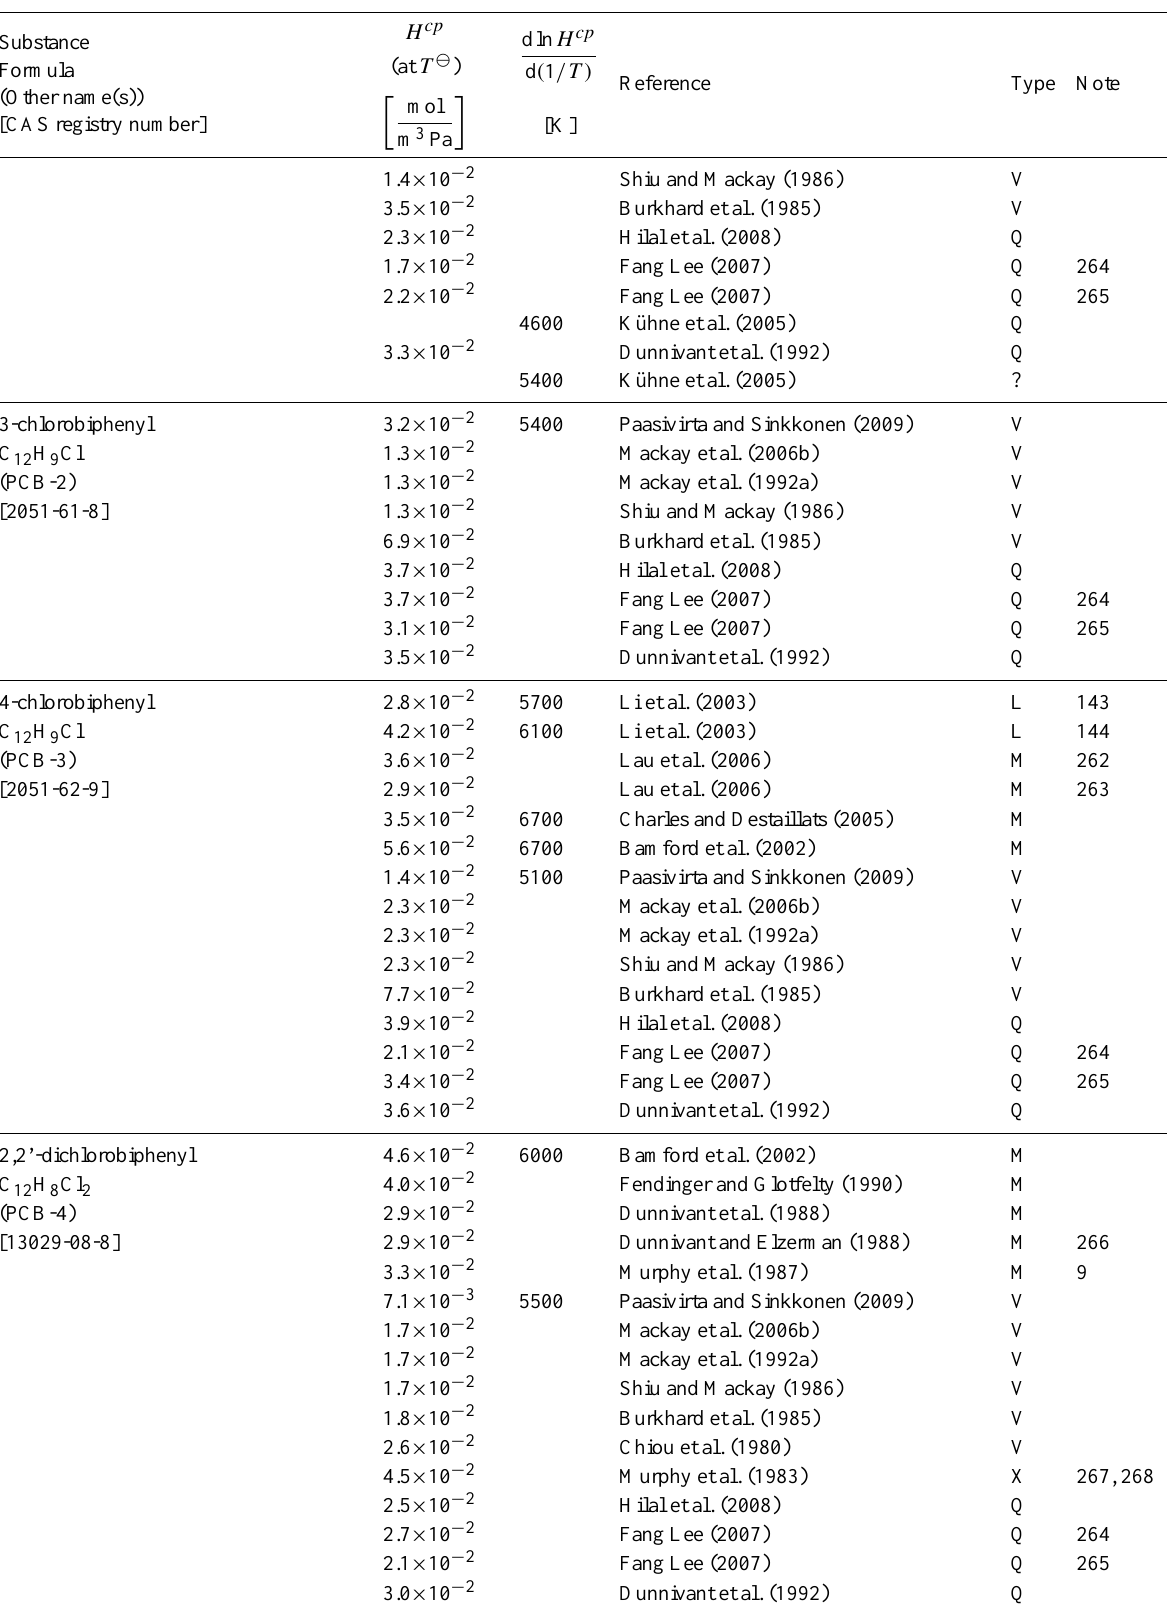
Table 6: Henry’s law constants for water as solvent